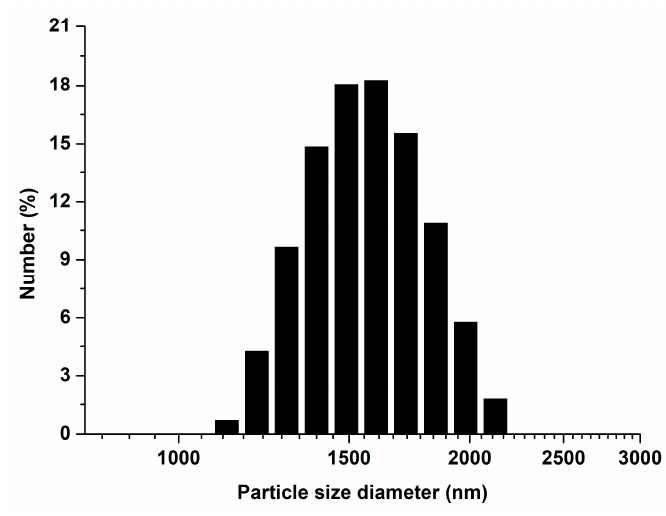
Figure 1. Particle size distribution of ZnO NPs.